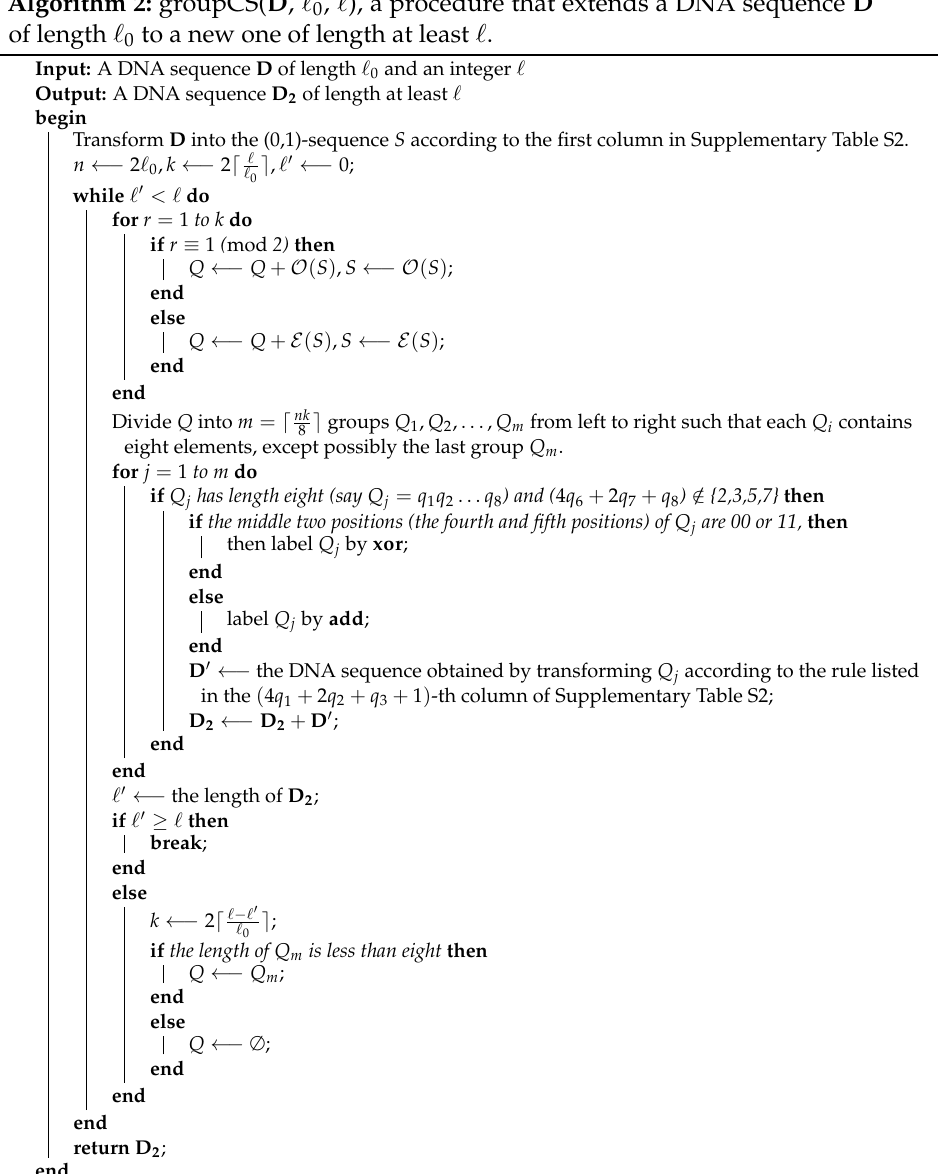
Algorithm 2: groupCS( D , (cid:96) 0 , (cid:96) ), a procedure that extends a DNA sequence